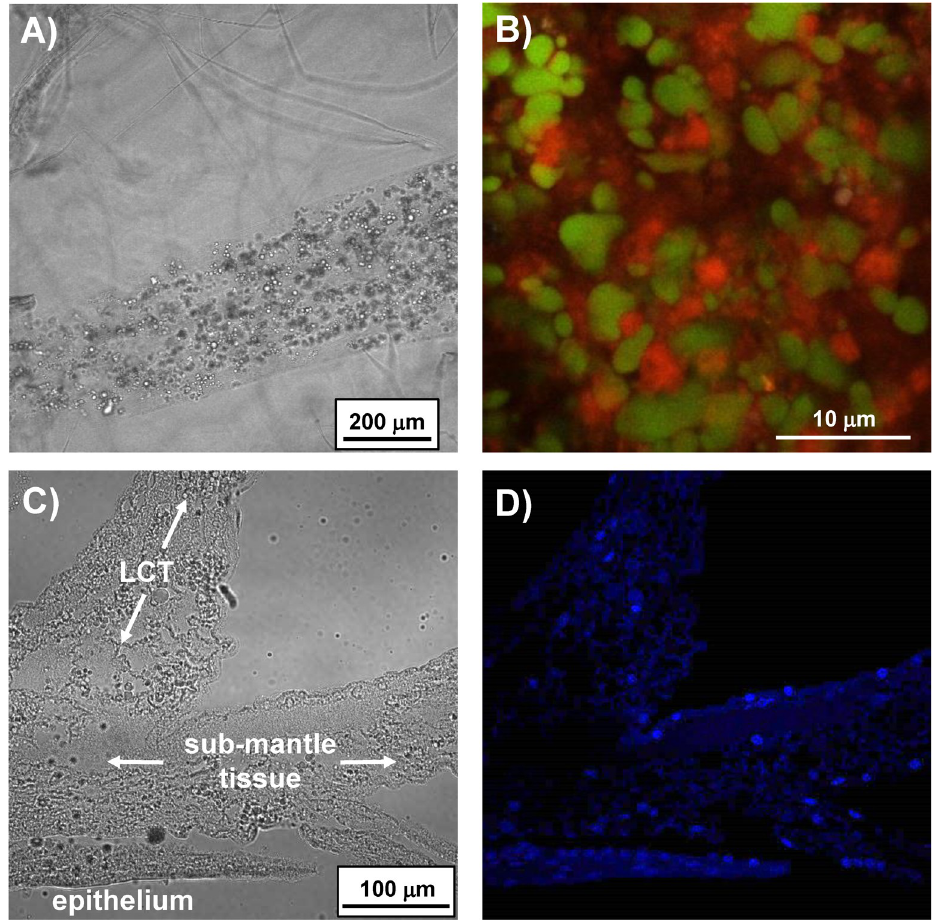
Brightfield and D) confocal image of a sagittal section of LCT and submantle tissue stained with DAPI showing the presence of nuclei throughout. An epithelial layer is also present along the bottom